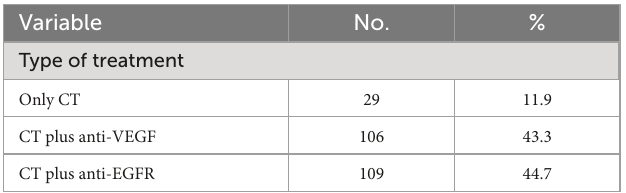
TABLE 1 Clinico-pathological characteristics of